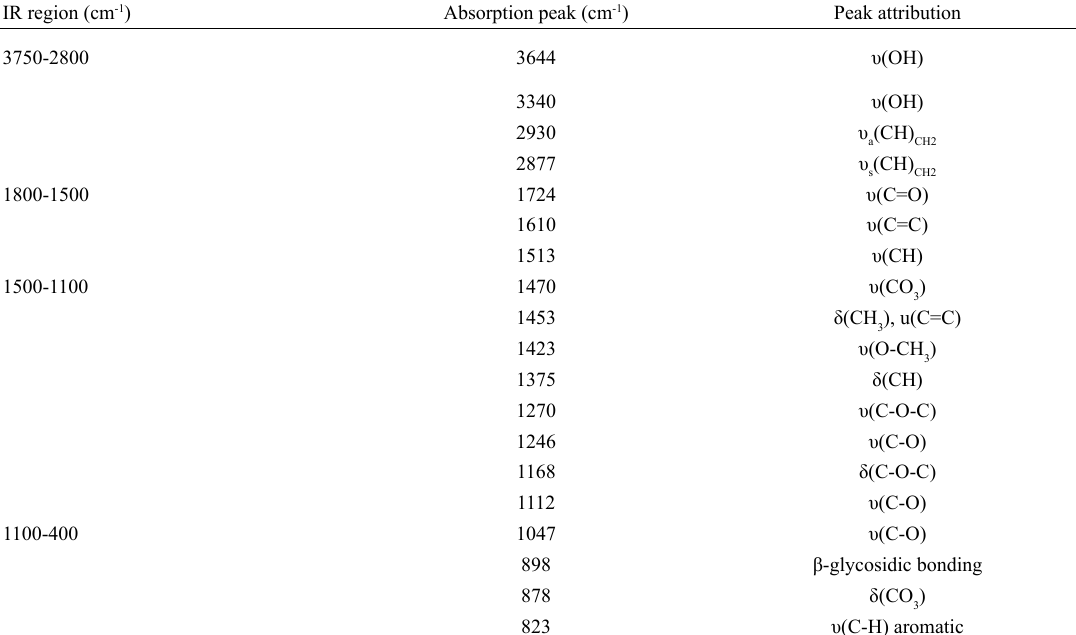
Table 1. IR bands and their proposed associations to the infrared spectra of fiber components. υ = stretching vibrations, δ= deformation bands. IR region (cm -1